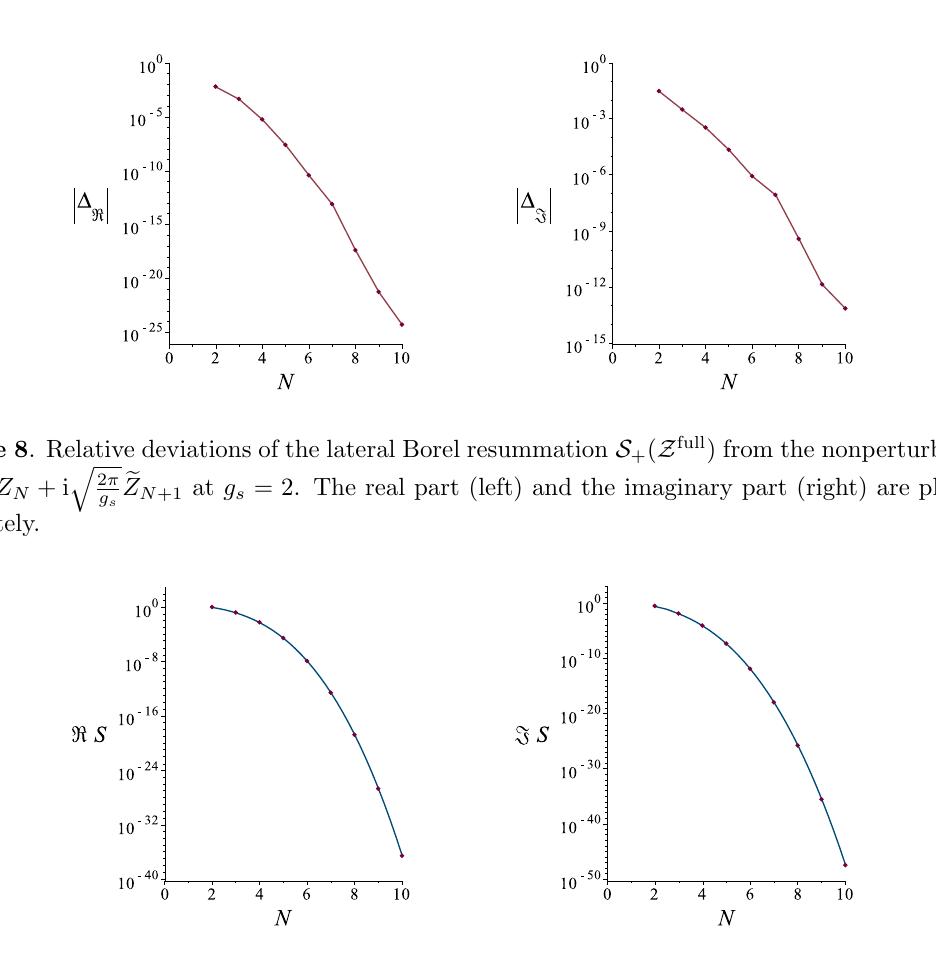
Figure 9 . Comparison of the nonperturbative result e Z N + i Borel resummation S + ( e Z full ) (blue solid line) at g s = 2. The real part (left) and the imaginary part (right) are plotted separately.